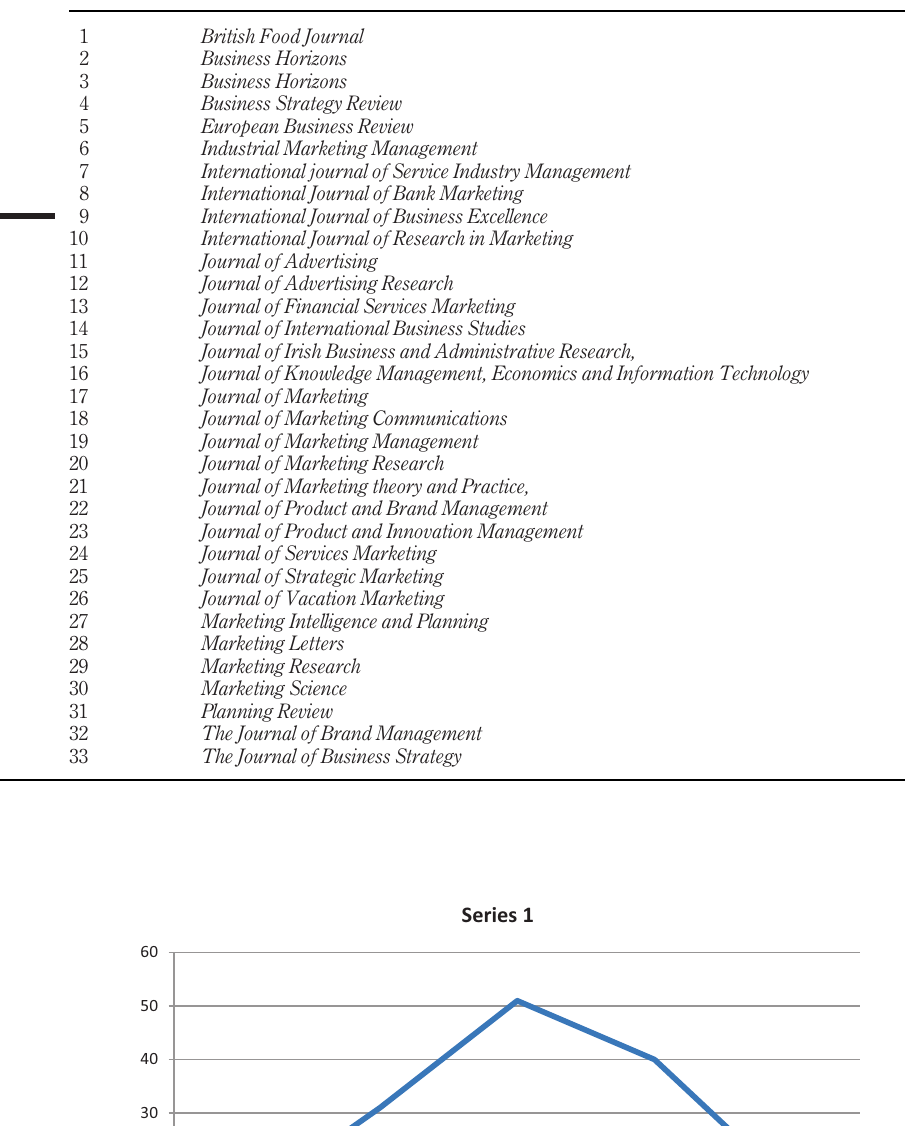
Figure 2. Number of positioning (de fi nition) related